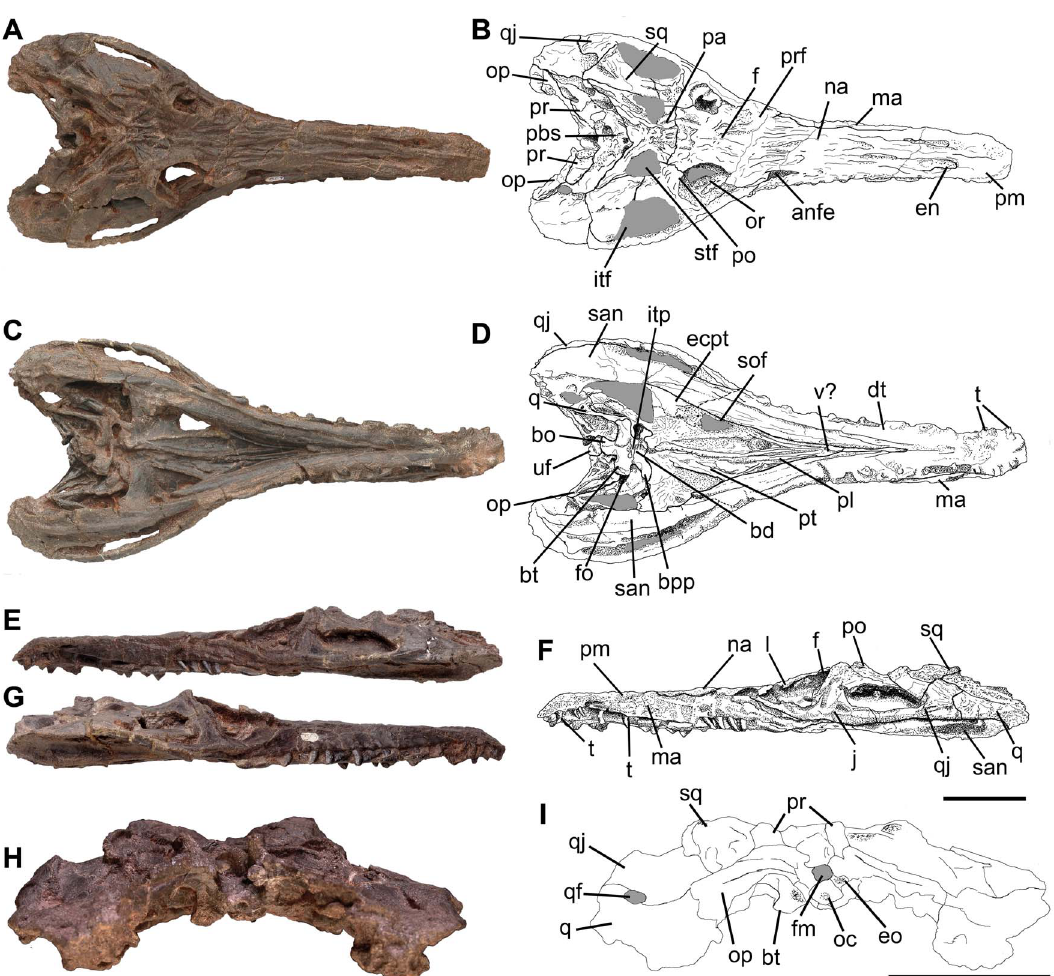
Figure 2. Skull of Pseudochampsa ischigualastensis (PVSJ 567) (A, B) in dorsal, (C, D) ventral, (E, F) left lateral, (G) right lateral, and (H, I) occipital views. Abbreviations: anfe, antorbital fenestra; bo, basioccipital; bpp, basipterygoid process; bd, basisphenoidal depression; bt, basal tubera; dt, dentary; ecpt, ectopterygoid; eo, exoccipital; en, external naris; f, frontal; fm, foramen magnum; fo, fenestra ovalis; itf, infratemporal fenestra; itp, intertuberal plate; j, jugal; l, lacrimal; ma, maxilla; na, nasal; oc, occipital condyle; op, opisthotic; or, orbit; pa, parietal; pbsp, parabasisphenoid; pl, palatine; pm, premaxilla; po, postorbital; pr, prootic; prf, prefrontal; pt, pterygoid; q, quadrate; qf, quadrate foramen; qj, quadratojugal; san, surangular; sof, suborbital fenestra; stf, supratemporal fenestra; sq, squamosal; t, tooth; uf, indeterminate bone fragment; v?, vomer?. Scale bars equal 5